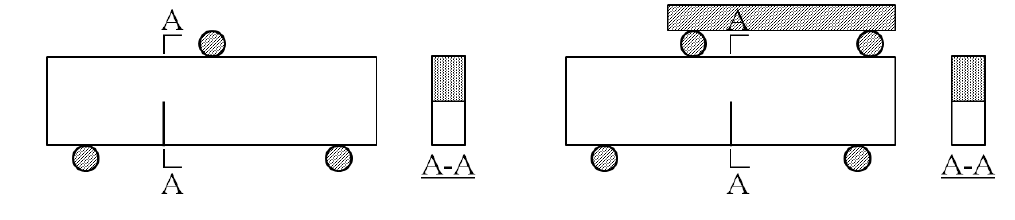
( a ) Single edge notched three-point-bend (SENB). ( b ) Asymmetric four-point-bend (AFPB).